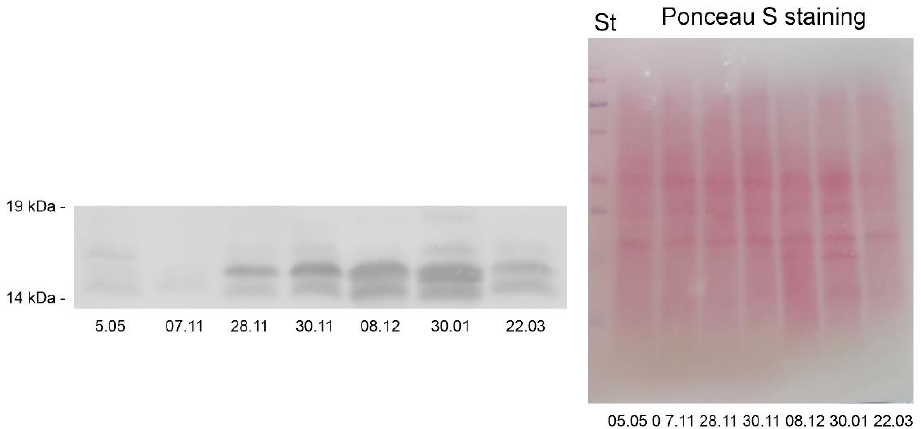
Figure 9. Representative Western blots of ELIPs ( left ) in leaves of Haberlea rhodopensis after exposure to low temperatures during cold acclimation (CA, period: 7–28 November), freezing stress (FS, 30 November, − 10 ◦ C), freezing-induced desiccation (FS + D, period: 8 December–30 January) and after recovery of plants in early spring (R; period: 22 March) under natural ex situ environmental conditions. 30 µg protein was applied per lane. The Ponceau S staining ( right ) of the membrane after blotting is presented on the right. St: Precision Plus Dual Color Protein™ Prestained Standards (Bio-Rad, Hercules, CA, USA).